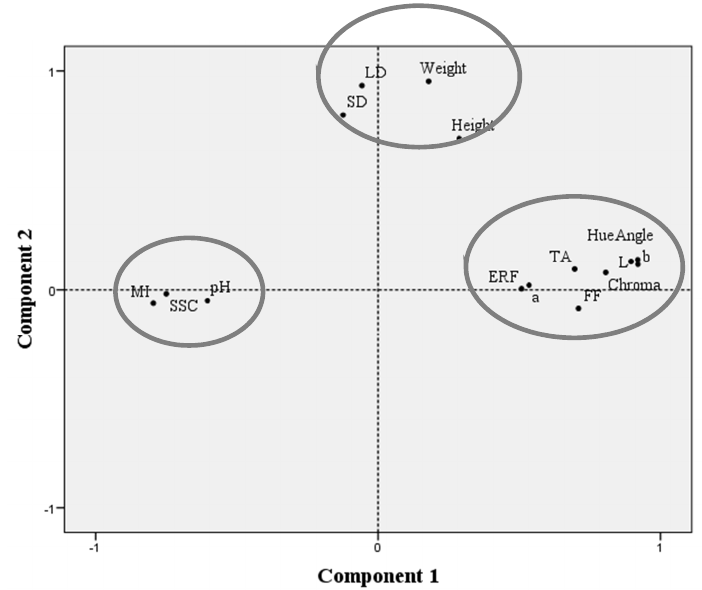
Figure 4. Principal component analysis using the whole dataset of sweet cherry Early Bigi grafted on SL 64 and Maxma 60 rootstocks. Analyzed parameters: biometric attributes (weight, height, larger diameter (LD) and smaller diameter (SD)); texture parameters (epidermis rupture force (ERF) and flesh firmness (FF)); maturity evaluation parameters (pH, titratable acidity (TA), soluble solids content (SSC) and maturity index (MI)); chromatic parameters ( L* , a *, b *, chroma and hue angle).